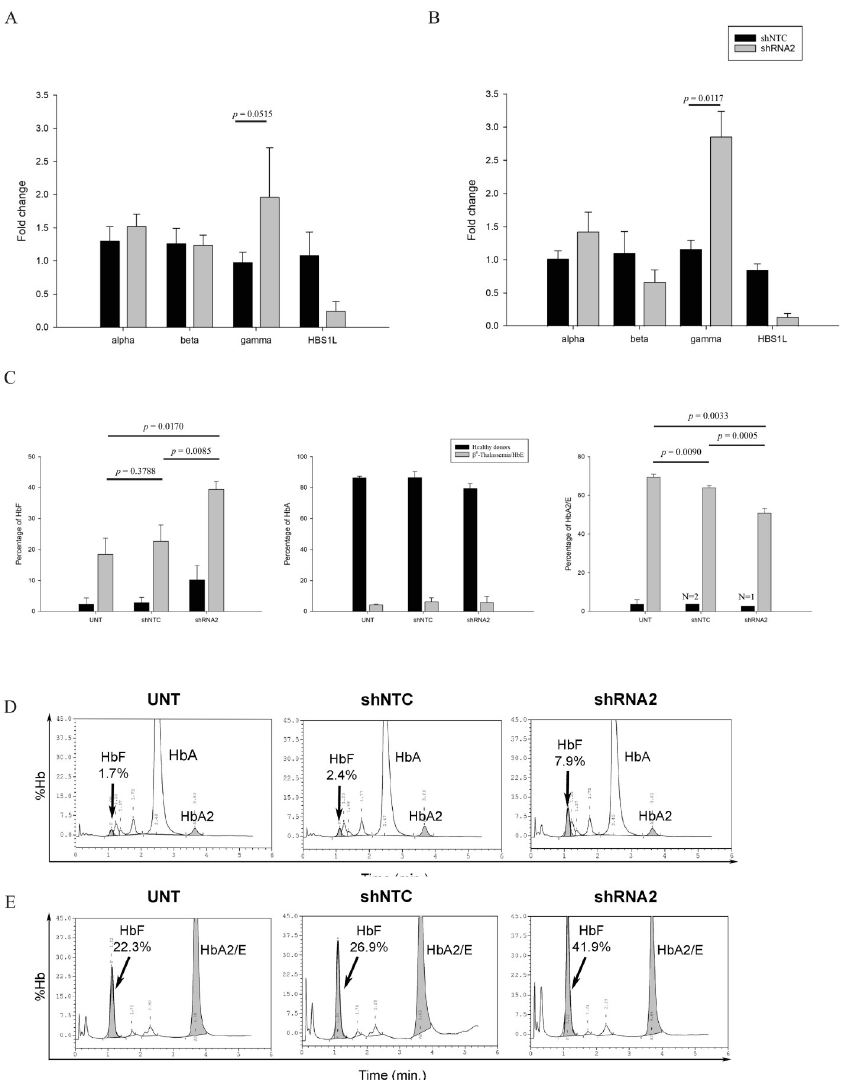
Fig 5. Expression of α , β and γ -globin mRNAs after shRNA2 transduced erythroblast along with the amount of HBS1L remains. Healthy donors on day 8, (A); β 0 -Thalassemia/HbE patients on day 10 (B) along with the amount of HBS1L remains. The percentages of HbF, HbA and HbA2/E analyzed by HPLC analysis on day 14 of erythroblasts from healthy donors and β 0 -thalassemia/HbE patients treated with shRNA2 (C). Data are represented as mean ± SD. (N = 3, each). The representative chromatograms of HPLC analysis: healthy donor (D) and β 0 -thalassemia/HbE patient (E).